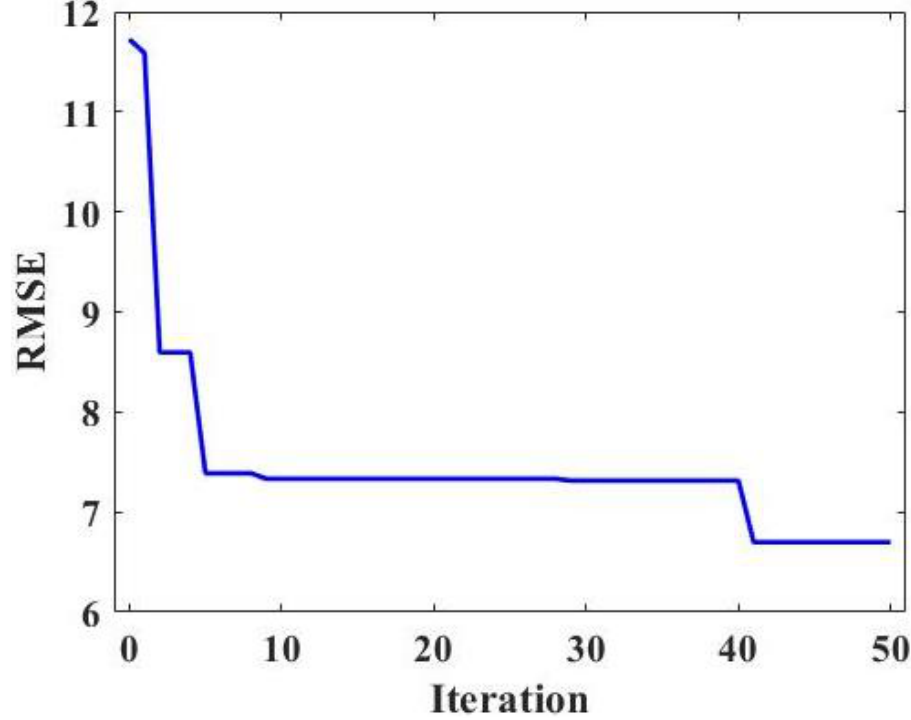
Figure 2. Relationship between the iteration and RMSE.